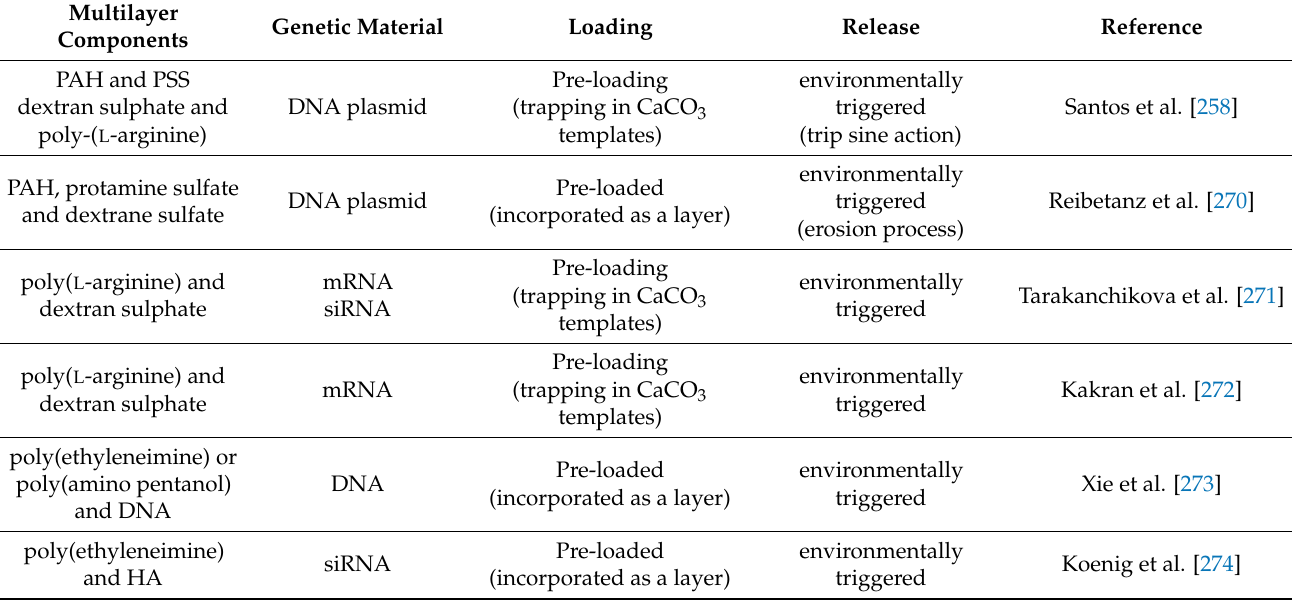
Table 3. Summary of multilayered capsules used for gene